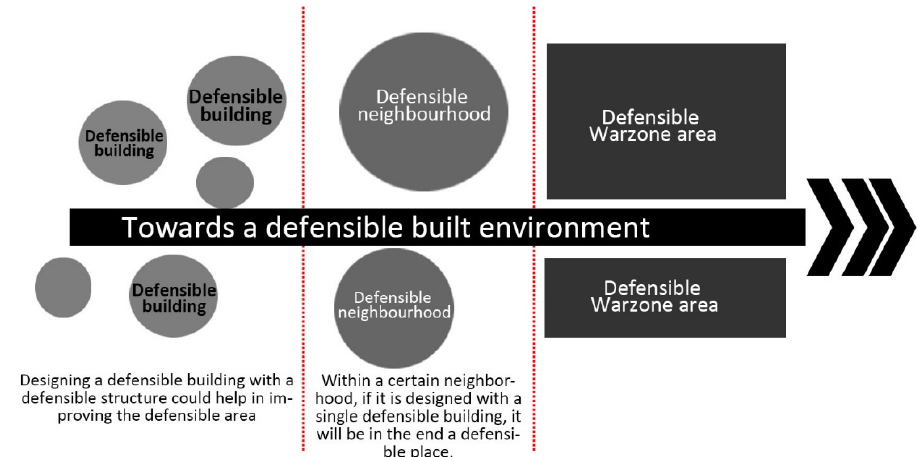
Figure 1. Diagram illustrating the idea of achieving a defensible environment by designing and repeating defensible guidelines on buildings as a smaller scale unit. Source: (Y.M.).